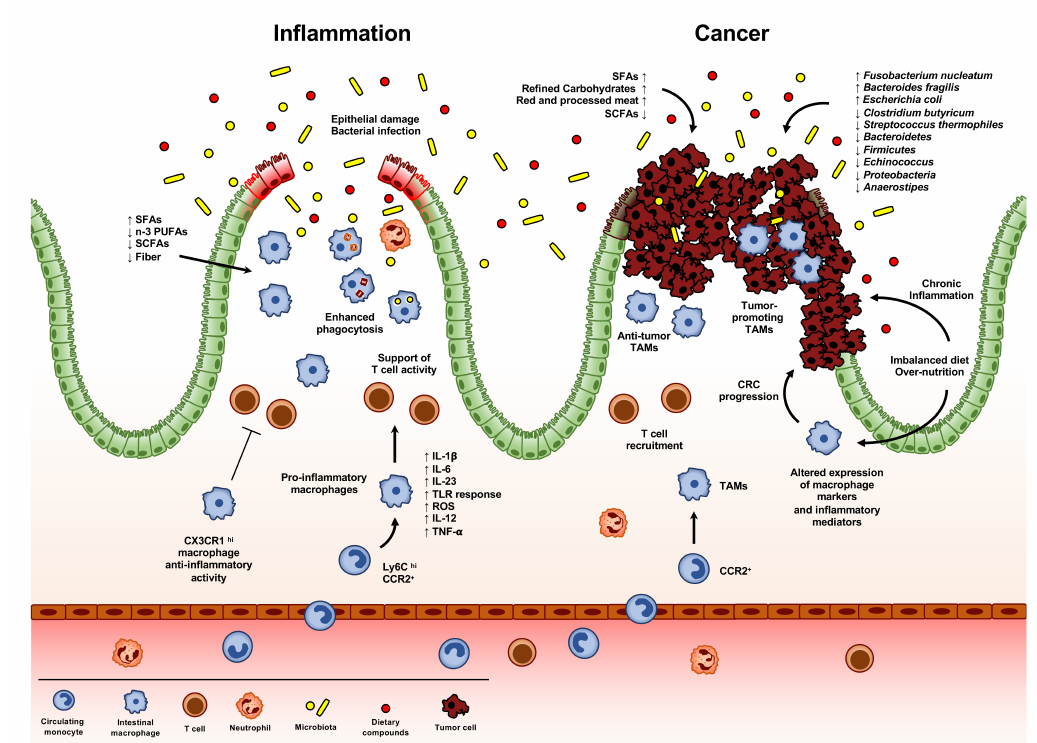
Figure 3. Intestinal macrophages in inflammation and cancer. Alteration of intestinal immune homeostasis may result in acute or chronic inflammation. This typically occurs during inflammatory bowel disease (IBDs), damage of the epithelial layer, or infection. Dietary components can exert either beneficial or detrimental e ff ects in these processes, activating a pro-inflammatory response in macrophages, like saturated fatty acids (SFAs), or preventing an inflammatory response, like short-chain fatty acids (SCFAs), fibers, or n-3 polyunsaturated fatty acids (n-3 PUFAs). This state of inflammation is characterized by the recruitment and accumulation of Ly6C hi CCR2 + monocytes, which di ff erentiate in pro-inflammatory macrophages, able to secret inflammatory molecules, such as IL-1 β , IL-6, IL-23, ROS, IL-12 and TNF- α , to promptly respond to TLR engagement and to support T cell activity. On the other hand, CX3CR1 hi macrophages maintain their pro-resolving function. During the resolution of inflammation, intestinal macrophages increase their phagocytic activity, engulfing epithelial apoptotic cells, neutrophils and invading bacteria. The composition of the gut